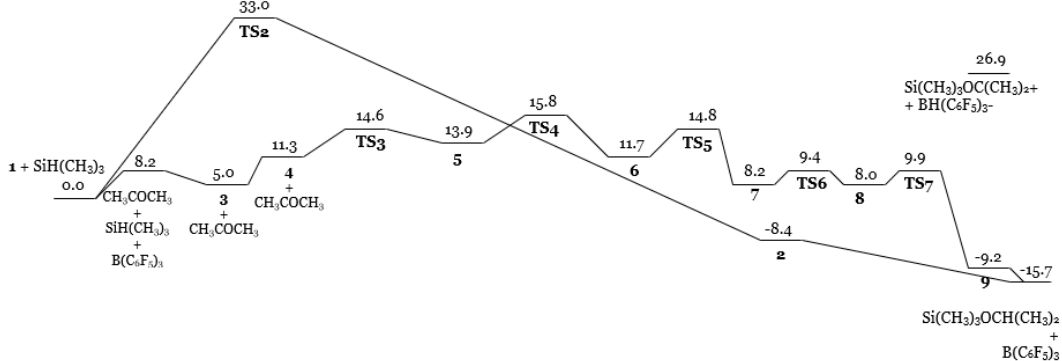
Figure 39. Quantum chemical calculations of the reaction coordinate diagram for the reduction reaction of acetone.